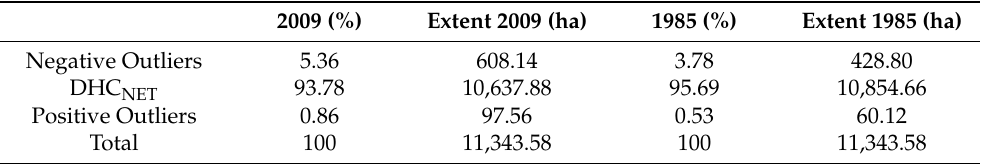
Figure 10. Example of a map of the standardized NDVI (NDVI) for the SAC of Monte Vulture. Elaboration based on the Landsat image acquired on 27 July 2009. Table 3. Degree of habitat consistency at network level (DHC NET ) and anomalous (positive and negative) areas for 2009 and 1985 for the investigated Natura 2000 SAC of Basilicata region.